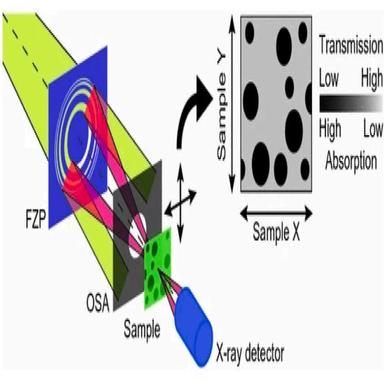
Principle of soft X-ray scanning transmission X-ray microscopy.